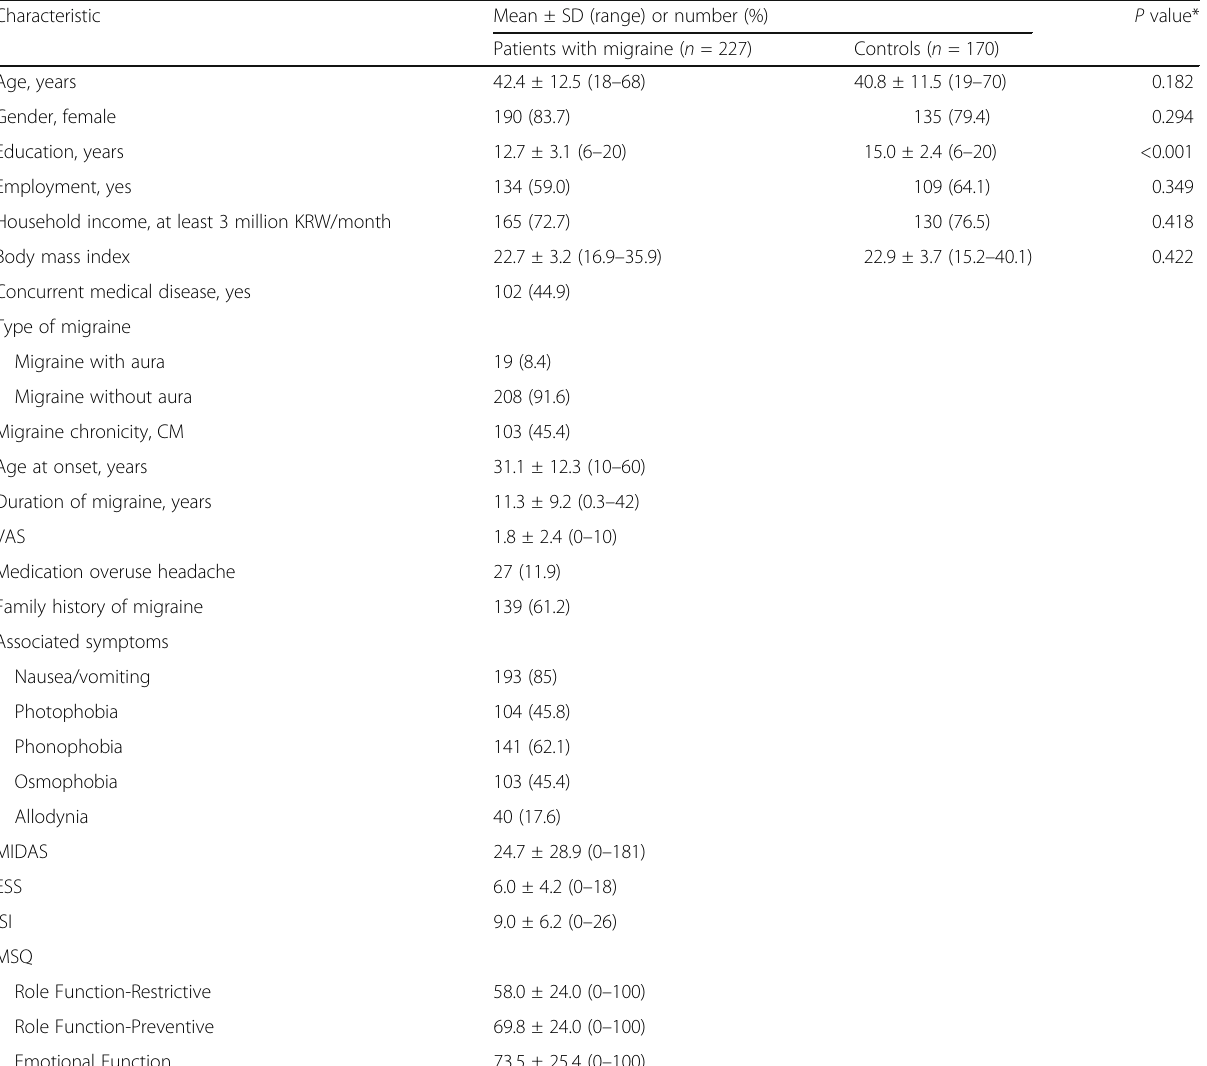
Table 1 Demographic, socioeconomic, and clinical characteristics of the participants